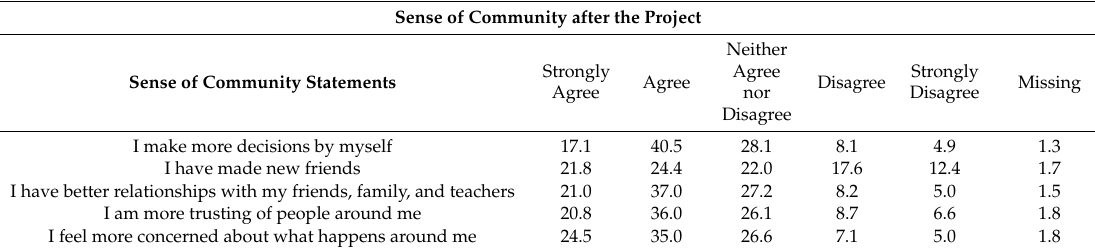
Table 8. Sense of community after the project.